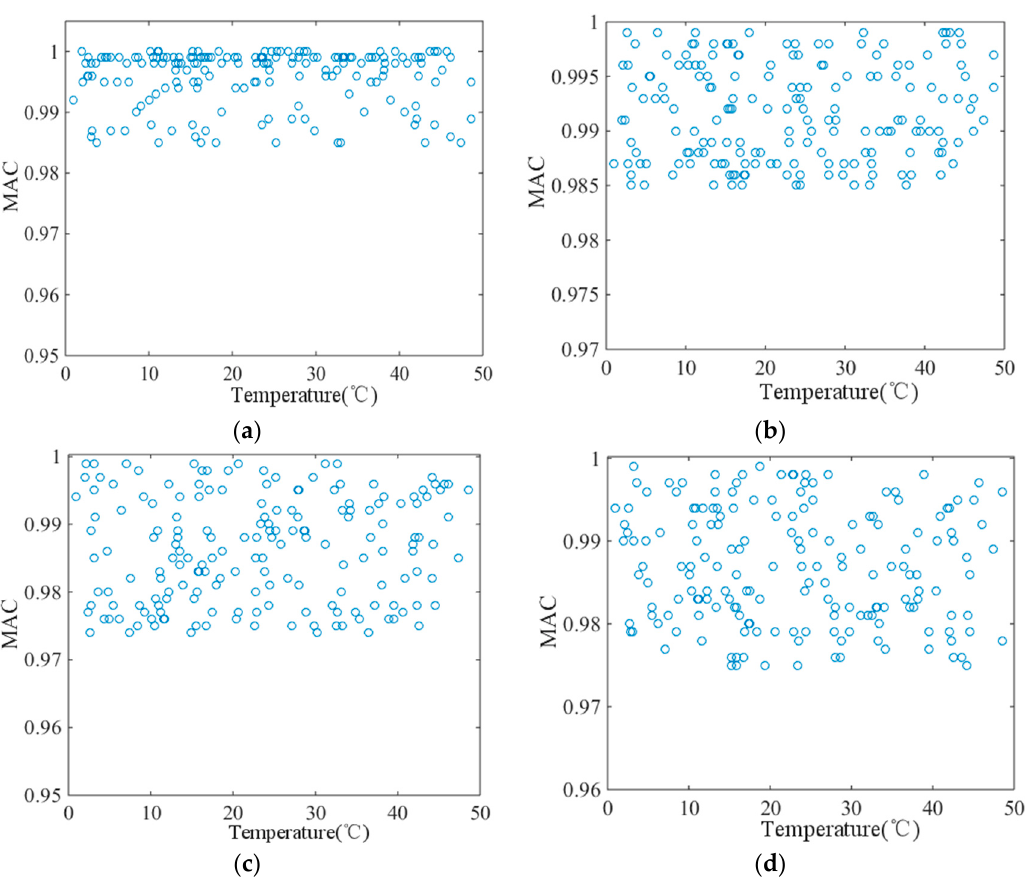
Figure 10. MAC vs. mean temperature. ( a ) 1st mode. ( b ) 2nd mode. ( c ) 3rd mode. ( d ) 4th mode.